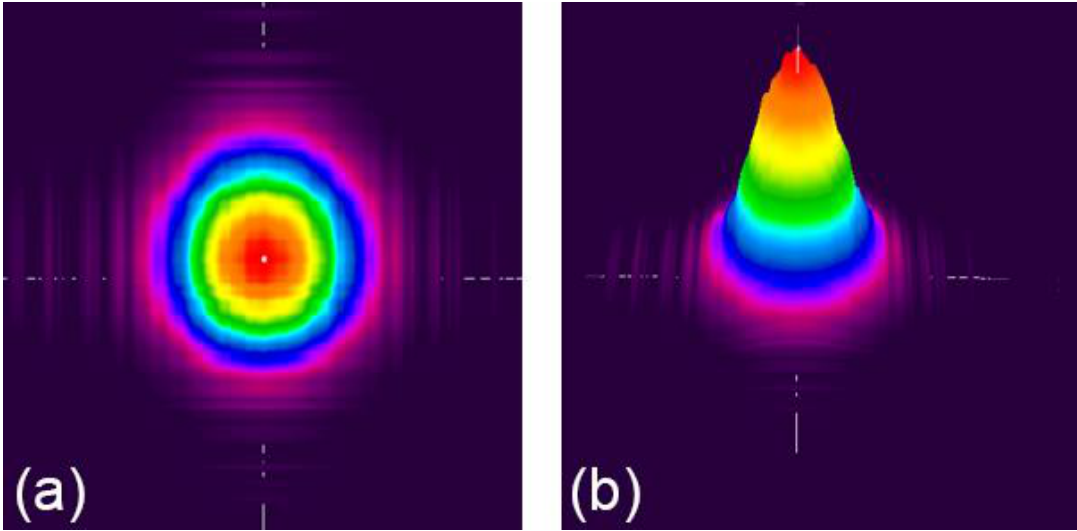
Figure 2. ( a ) 2D profile and ( b ) 3D profile of the excitation laser, when the lens is placed at the focal point. Table 1. Values of PuB radii for different position of forming lens and ratio of PuB/PrB radii. Lens Position, cm